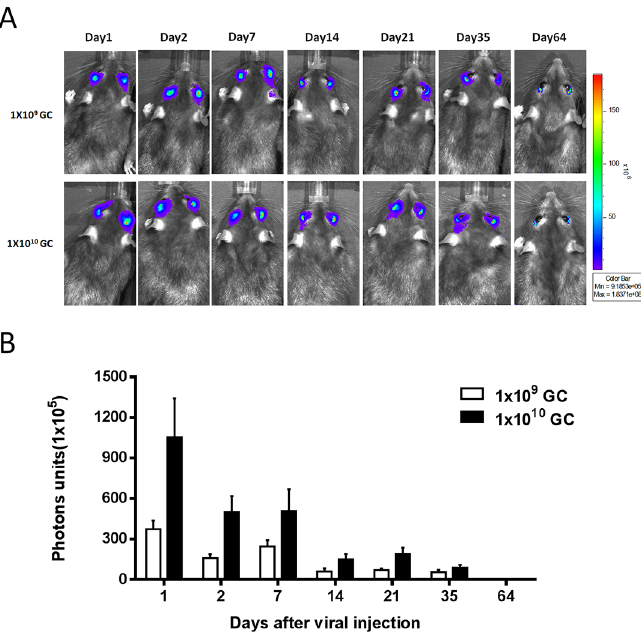
Fig 1. Viral dosage and duration of adenovirus-mediated gene delivery after a subconjunctival injection in the rats. (A) Bioluminescence images of rat eyes at day 1, 2, 7, 14, 28, 35 and 64 after a subconjunctival injection of Ad-Luci (1x10 9 and 1x10 10 GC/eye). (B) Luciferase activity was measured in unit of photons by bioluminescence analysis. Data are presented as the means ± SEM (n = 5).